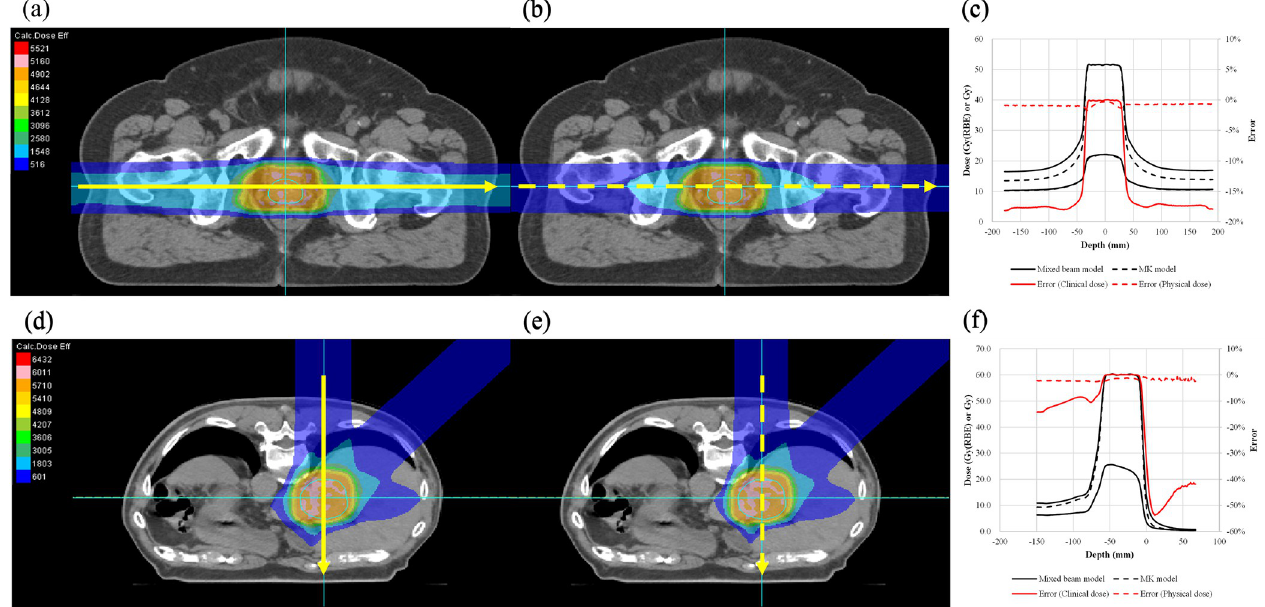
Fig 12. Comparison of clinical and physical dose distributions from the mixed beam and MK models. The PC case is prescribed to receive 51.6 Gy (RBE) in 12 fractions. This figure shows the dose distribution calculated with the (a) mixed beam model and (b) MK model. (c) The dose profiles, with differences between the RBE models, are shown by the yellow arrows. The liver case is prescribed to receive 60 Gy (RBE) in four fractions. The dose distributions shown are calculated with the (d) mixed beam model and (e) MK model. (f) The dose profiles with differences between the RBE models are shown by the yellow